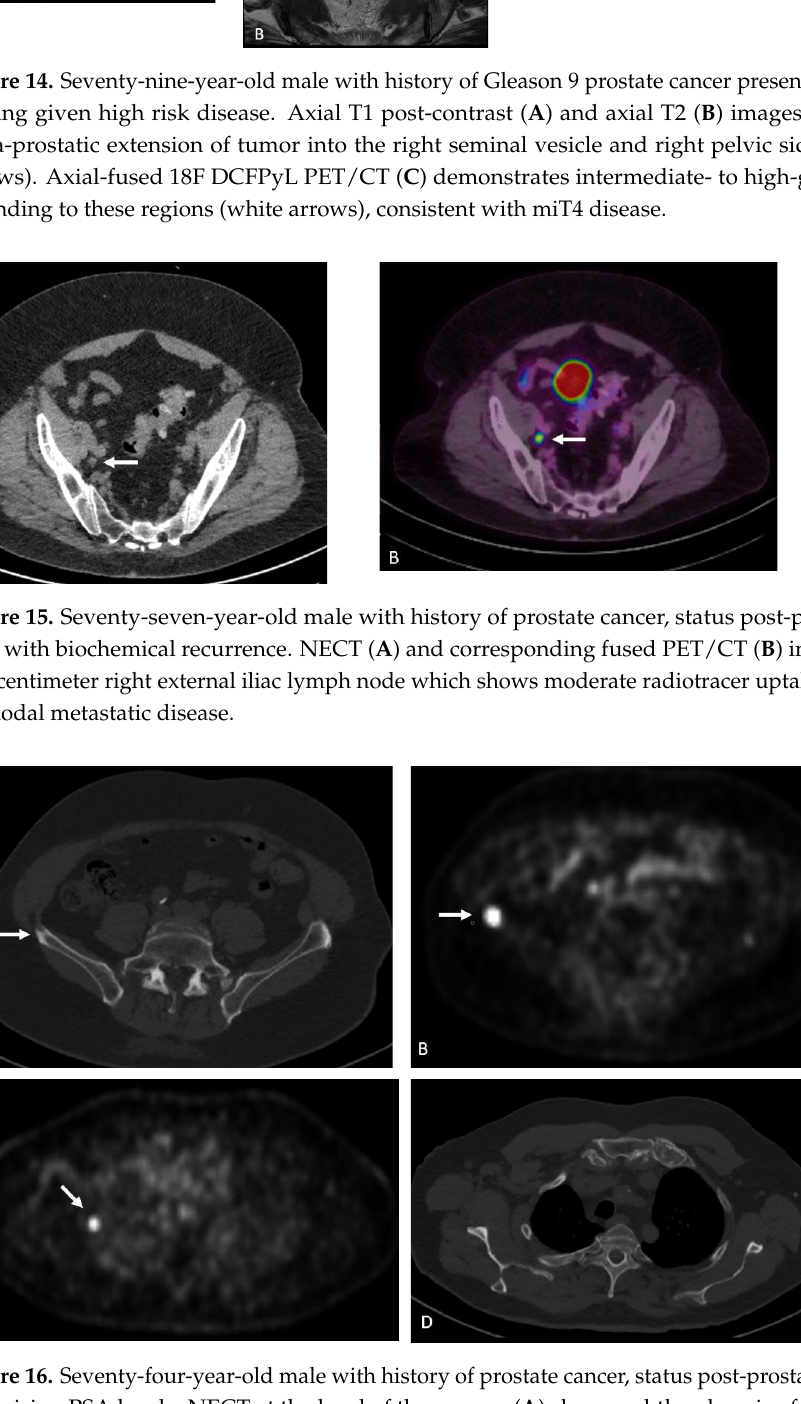
Figure 17. Ninety-two-year-old male with stage IV prostate cancer, status post-brachytherapy, now with biochemical recurrence. NECT image ( A ) shows brachytherapy seeds in the prostate base (ar- row) without a discernable abnormality. Corresponding 18F DCFPyL PET image ( B ) shows intense radiotracer uptake in the left prostate base and extending across midline. 1.9.3. Pearls and Pitfalls There are several pitfalls to be aware of when evaluating PET imaging, ranging from normal anatomic variants simulating disease, to benign and malignant non-prostate-re- lated disease uptake simulating metastatic prostate cancer. With imaging technology ad- vances, we have improved our diagnostic ability; however this comes at the cost of in- creased pitfalls which simulate disease. One such example is the visualization of sympa- thetic ganglia throughout the body as a result of improved PET image resolution. These ganglia, most commonly the celiac and stellate ganglia, can show low-grade uptake with Axumin and PSMA PET scans in up to 60% of cases [32,49] (Figure 18). Another pitfall with PSMA PET is the urinary excretion of a radiotracer mimicking a lymph node. This is especially true of the distal ureters, as their physiologic location can mimic a pelvic lymph node (Figure 19). This pitfall is much less common with Axumin PET, given its very slow renal excretion and the relatively early timing of the scan. Other confounders of disease include infectious/inflammatory etiologies of radiotracer uptake in the prostate gland, in- cluding iatrogenic causes such as biopsies, a fairly common occurrence, given the patient